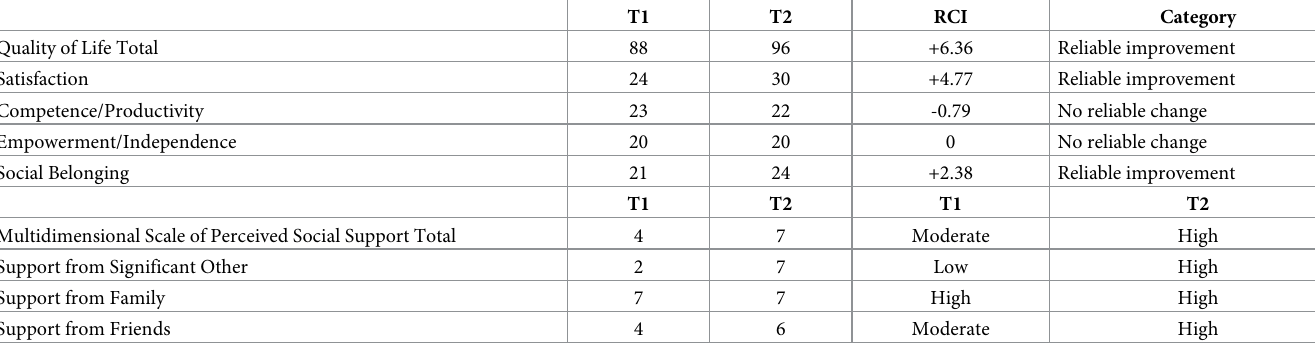
Table 6. Summary of QoLQ, RCI’s, and MSPSS categories for Mr.